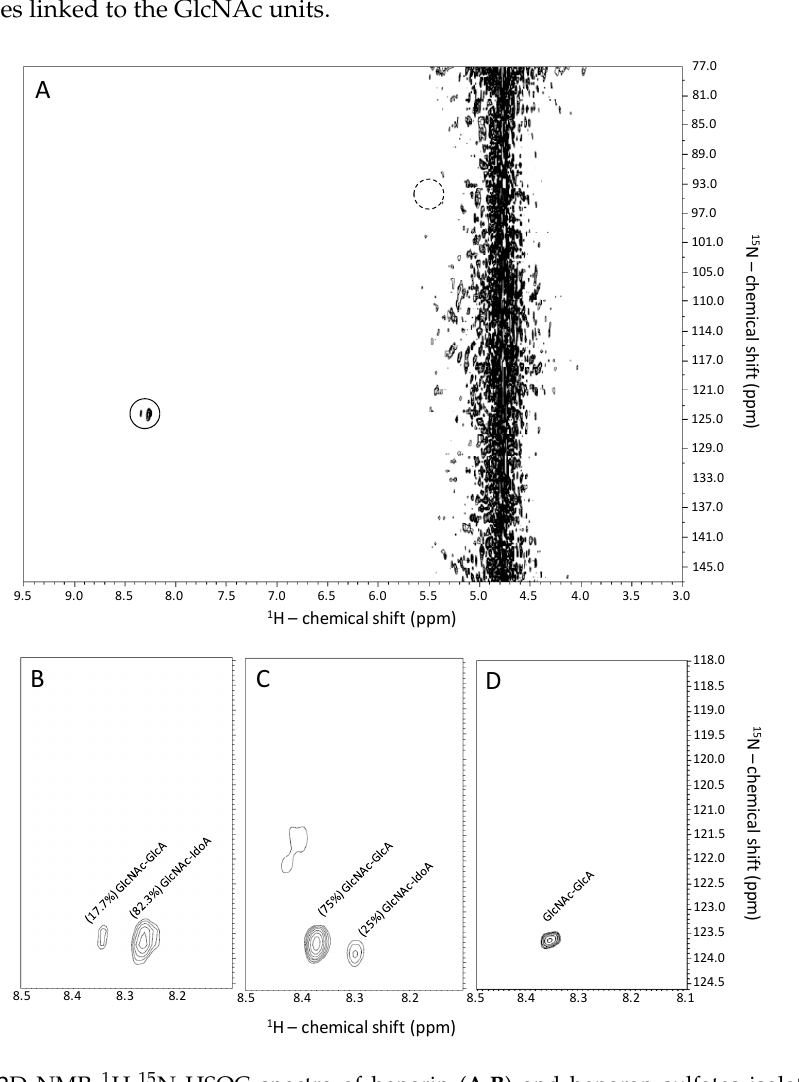
Figure 2. 2D NMR 1 H- 15 N HSQC spectra of heparin ( A and B ) and heparan sulfates isolated from Chinese Hamster Ovarian cells ( C ) and from the bivalve Nodipecten nodosus ( D ). Expansions are δ H / δ N 3.0–9.5/77.0–147.0 ppm ( A ) and δ H / δ N 8.1–8.5/118.0–124.6 ppm ( B – D ) for samples (10 mg/mL) dissolved in 50 mM sodium acetate buffer, 12.5% D 2 O (pH 4.5), 0.1% sodium azide. The solid and dashed circles highlight the observed and theoretical regions for the 1 H- 15 N cross-peaks of N -acetyl glucosamine (GlcNAc) and N -sulfo-glucosamine (GlcNS) units, respectively. Spectra were recorded at 18.8 T and 25 °C.